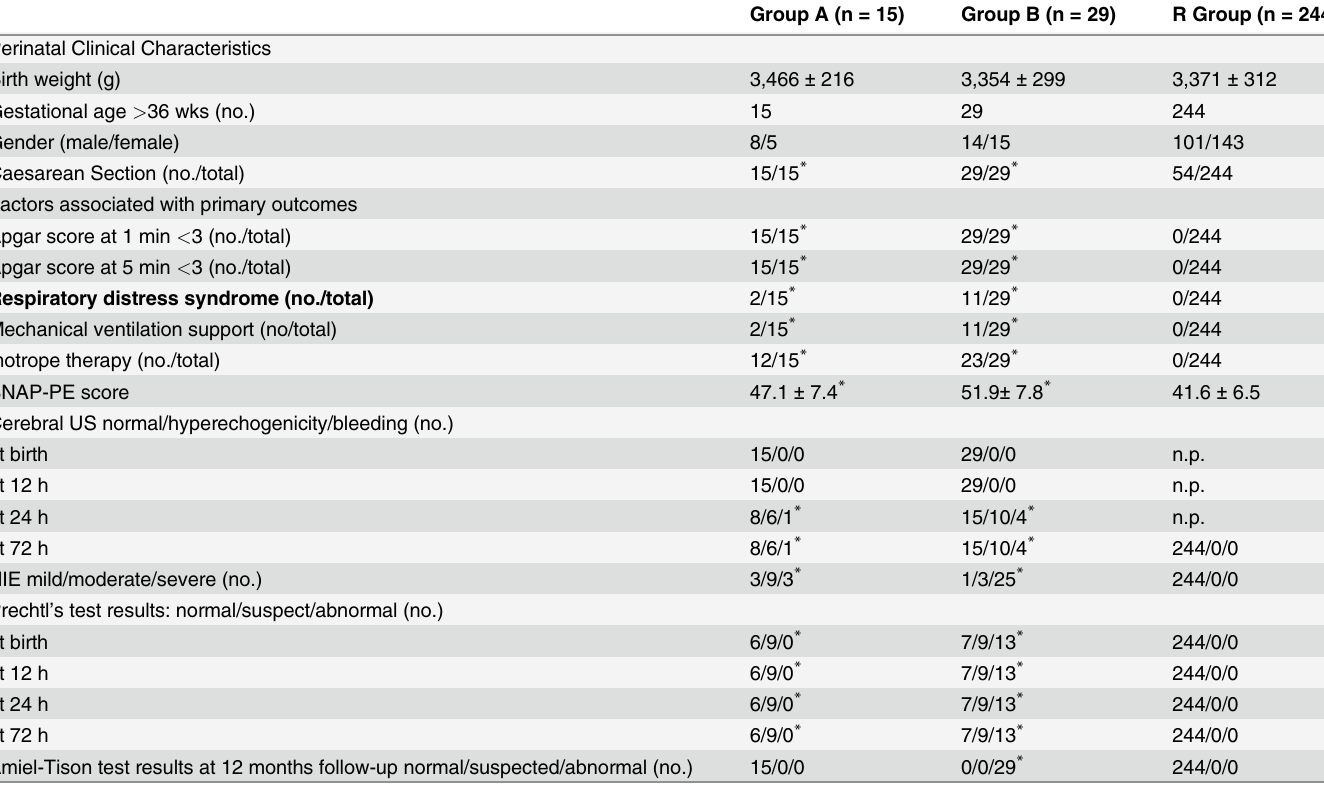
Table 1. Perinatal clinical characteristics and outcomes in asphyxiated newborns with normal (Group A) or abnormal (Group B) neurological outcome and in healthy subjects (Reference Group, R